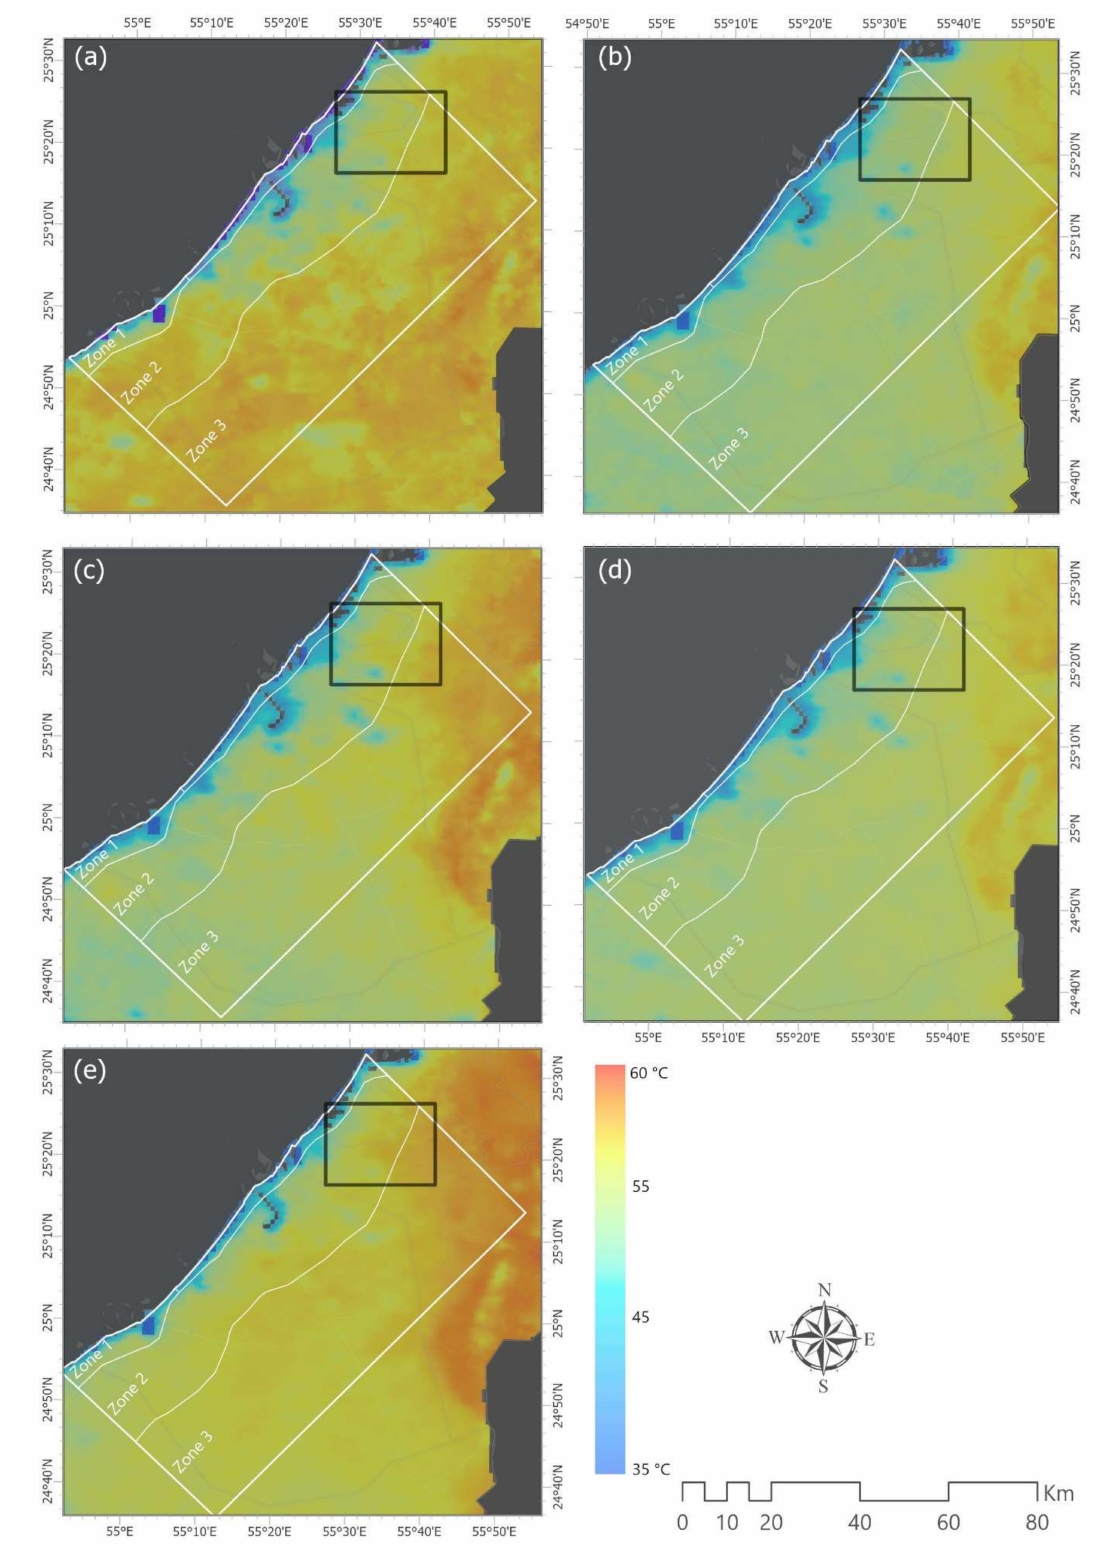
Figure 6. Temporal Evolution of LST Daytime over the UAE in August: ( a ) 2000; ( b ) 2005; ( c ) 2010; ( d ) 2015; ( e )